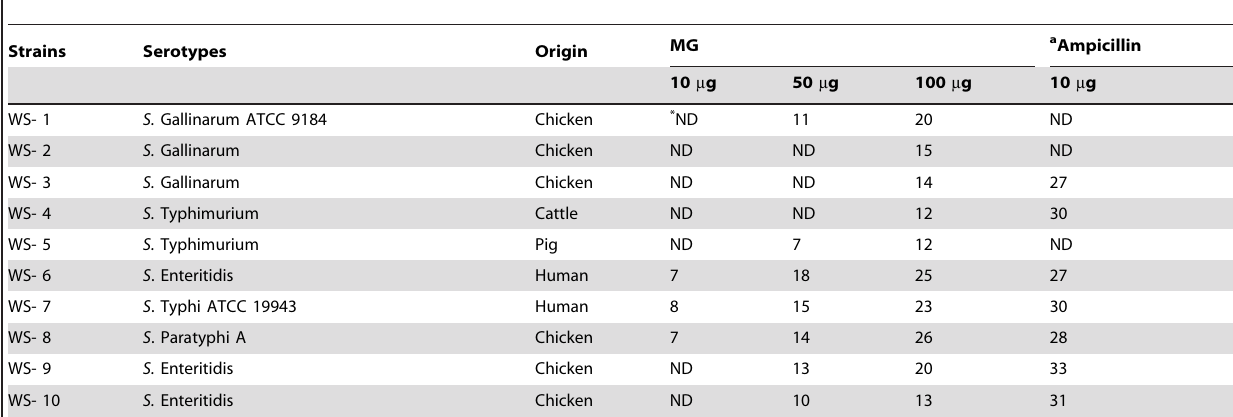
Table 2. Antimicrobial activity (as the inhibition zone diameter) of methyl gallate (MG) and ampicillin against Salmonella .